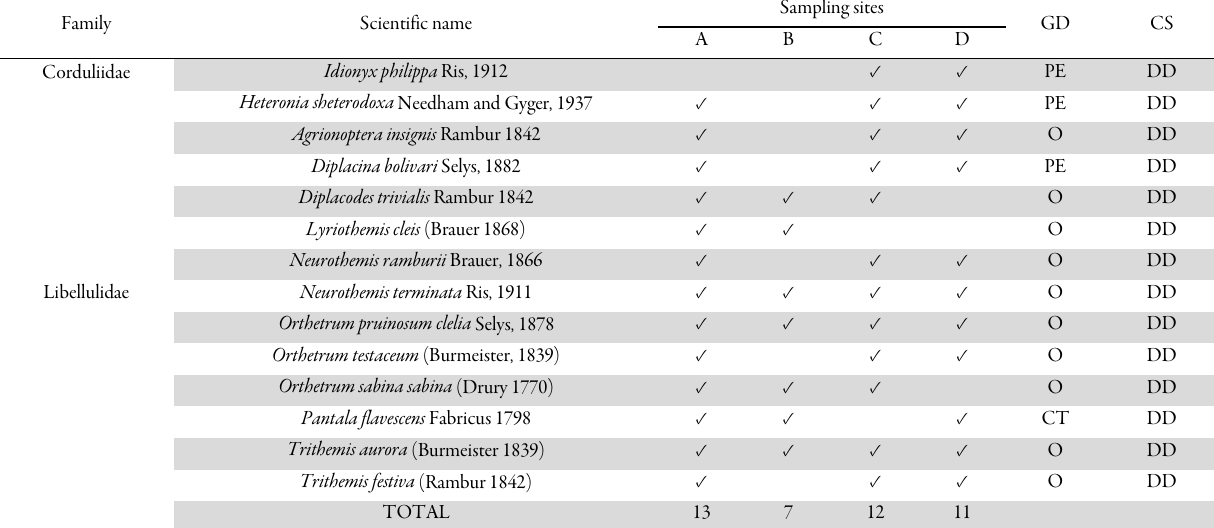
Table 2. Anisopteransrecorded in MHRWS, Davao Oriental Philippines